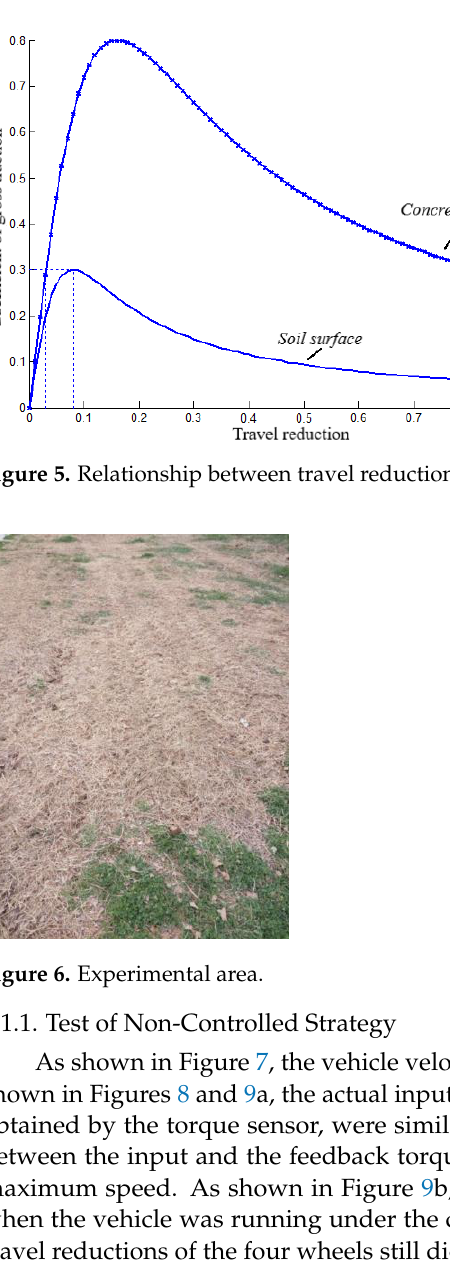
Figure 8. Motor output torque of non-controlled strategy. ( a ) ( b ) Figure 9. Motor feedback torque and travel reduction of non-controlled strategy.( a ) Motor feedback torque; ( b ) Travel reduction. 3.1.2. Test of SMC The target travel reduction was selected as 0.08, and the vehicle speed exceeded 1 m/s at t = 5 s, as shown in Figure 10. The travel reductions of the four wheels were similar to 0.08 after t = 5 s, as shown in Figure 11. Therefore, the travel reductions exceeded the set range of 0 – 0.2, and the vehicle started to run in straight under SMC at t = 5 s.